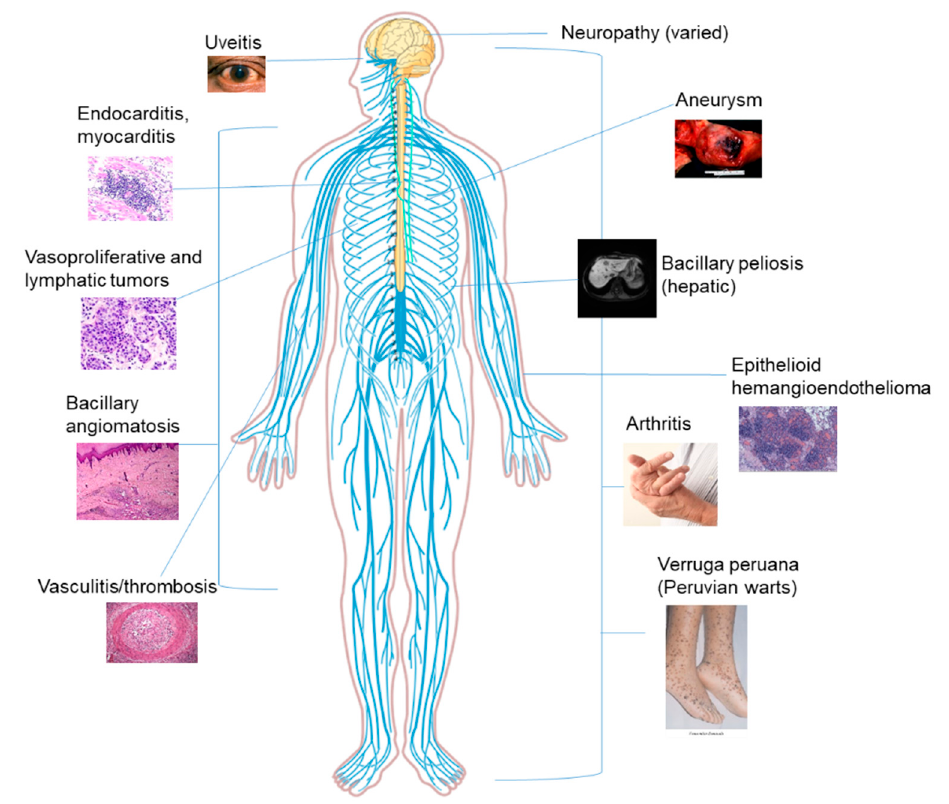
Figure 1. The clinical manifestations of human Bartonellosis.